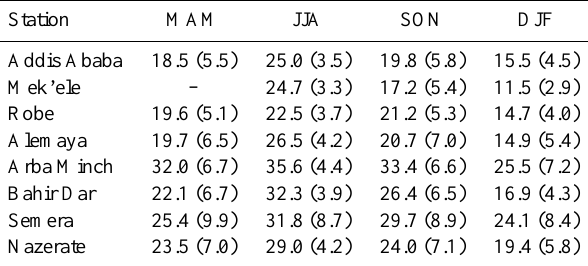
Table 7. The seasonal mean PWV (mm) and standard deviation (mm) in brackets as determined from the eight ground-based GPS receivers used in this